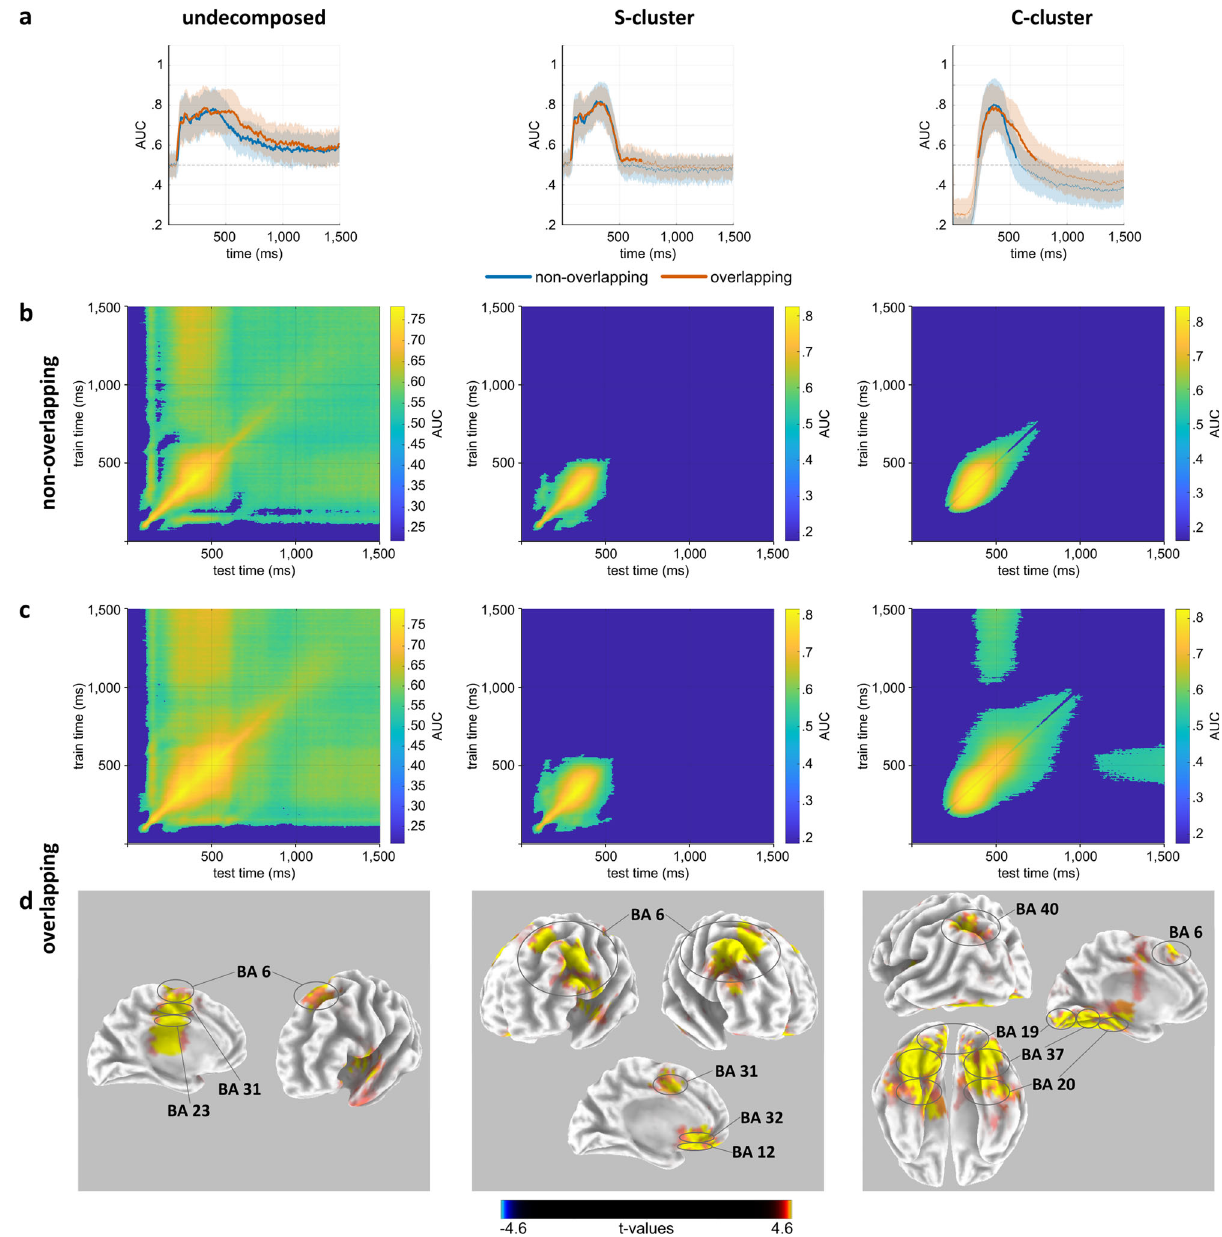
Fig. 2 Results of the MVPA comparing the placebo session and the MPH session in Nogo trials. Results of the MVPA comparing the placebo session and the MPH session in Nogo trials in the undecomposed EEG data, in the RIDE S-cluster and in the RIDE C-cluster of N = 78 participants. Figure part a shows the AUC for the diagonal activity in the non-overlapping condition (blue line) and the overlapping condition (orange line); thick lines indicate signi fi cant above-chance classi fi cation, the shading around the line represents the standard deviation of the AUC across the sample. Figure part b shows the temporal generalization matrices for the non-overlapping condition, whereas fi gure part c shows the temporal generalization matrices for the overlapping condition; the color scaling re fl ects the level of classi fi cation accuracy as indicated by the AUC. d shows the results of the sLORETA in the time window of signi fi cant AUC in the overlapping condition. Color indicates